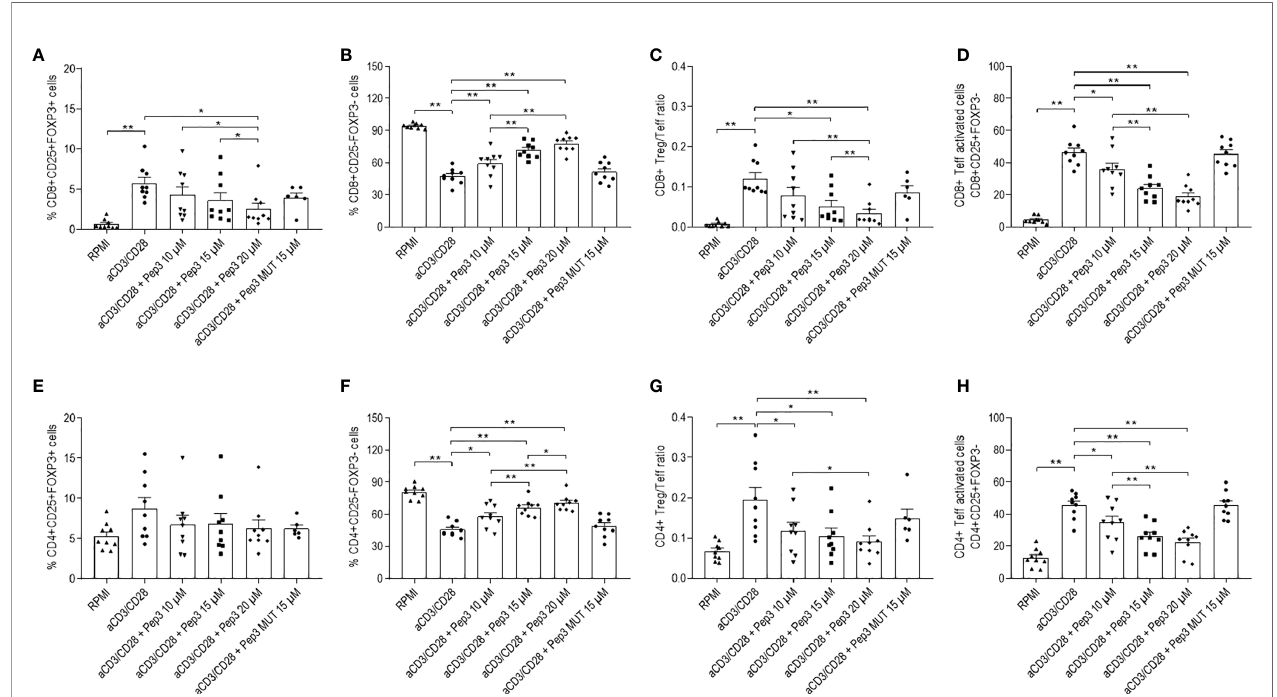
FIGURE 2 | Frequency of T cell populations in PBMC from TC patients upon treatment with peptide 3 and subsequent stimulation with anti-CD3/CD28 beads for 6 days. Flow-cytometry analysis of TC PBMC following 10, 15, and 20 µM treatment relative to Pep3 and 15 µM treatment relative to Pep3 MUT and subsequent stimulation for 6 days with anti-CD3/CD28 beads. Graphs show the percentages upon CD3/CD28 stimulation of CD8+ Treg as CD8+CD25+FOXP3+ cells (A) , CD8+ Teff as CD8+CD25 − FOXP3 − cells (B) , CD8+ Treg/Teff ratio (C) , CD8+ Teff activated cells as CD8+CD25+FOXP3 − cells (D) , CD4+ Treg as CD4+CD25+FOXP3+ cells (E) , CD4+ Teff as CD4+CD25 − FOXP3 − cells (F) , CD4+ Treg/Teff ratio (G) , CD4+ Teff activated cells as CD4+ CD25+FOXP3- cells (H) . Data are expressed as mean ± SEM, and each dot corresponds to an individual TC patient (n = 9). Statistical signi fi cance was evaluated using Wilcoxon matched-pairs signed rank test. *p < 0.05, **p <